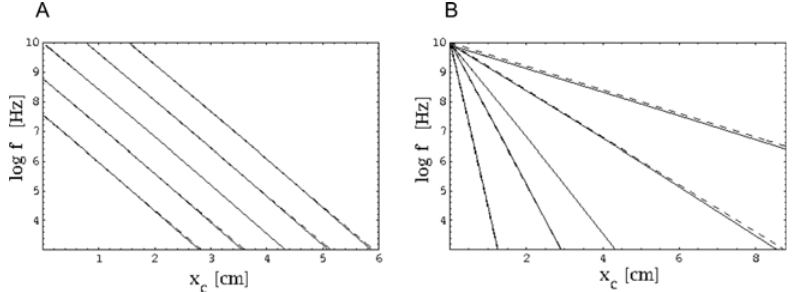
Figure 3. (a) E ( x )= E 0 e 2 a g ( x ) . Analytical prediction (dashed) together with the corresponding numerical evaluation (solid) for space dependence a) g ( x )= x 2 and b) g ( x )=2 ln( x + 1), respectively. For comparison, the full straight line displays the unmodified TM. (b) E ( x )= E 0 9 e 2 a 9 g ( x ) , using E 0 9 =10 2 E 0 and a 9 =3 a . Analytical prediction (dashed), together with the corresponding numerical evaluation (solid) for the space dependence a) g ( x )= x 2 and b) g ( x )=2 ln( x + 1), respectively. For comparison, the full straight line displays the unmodified TM.